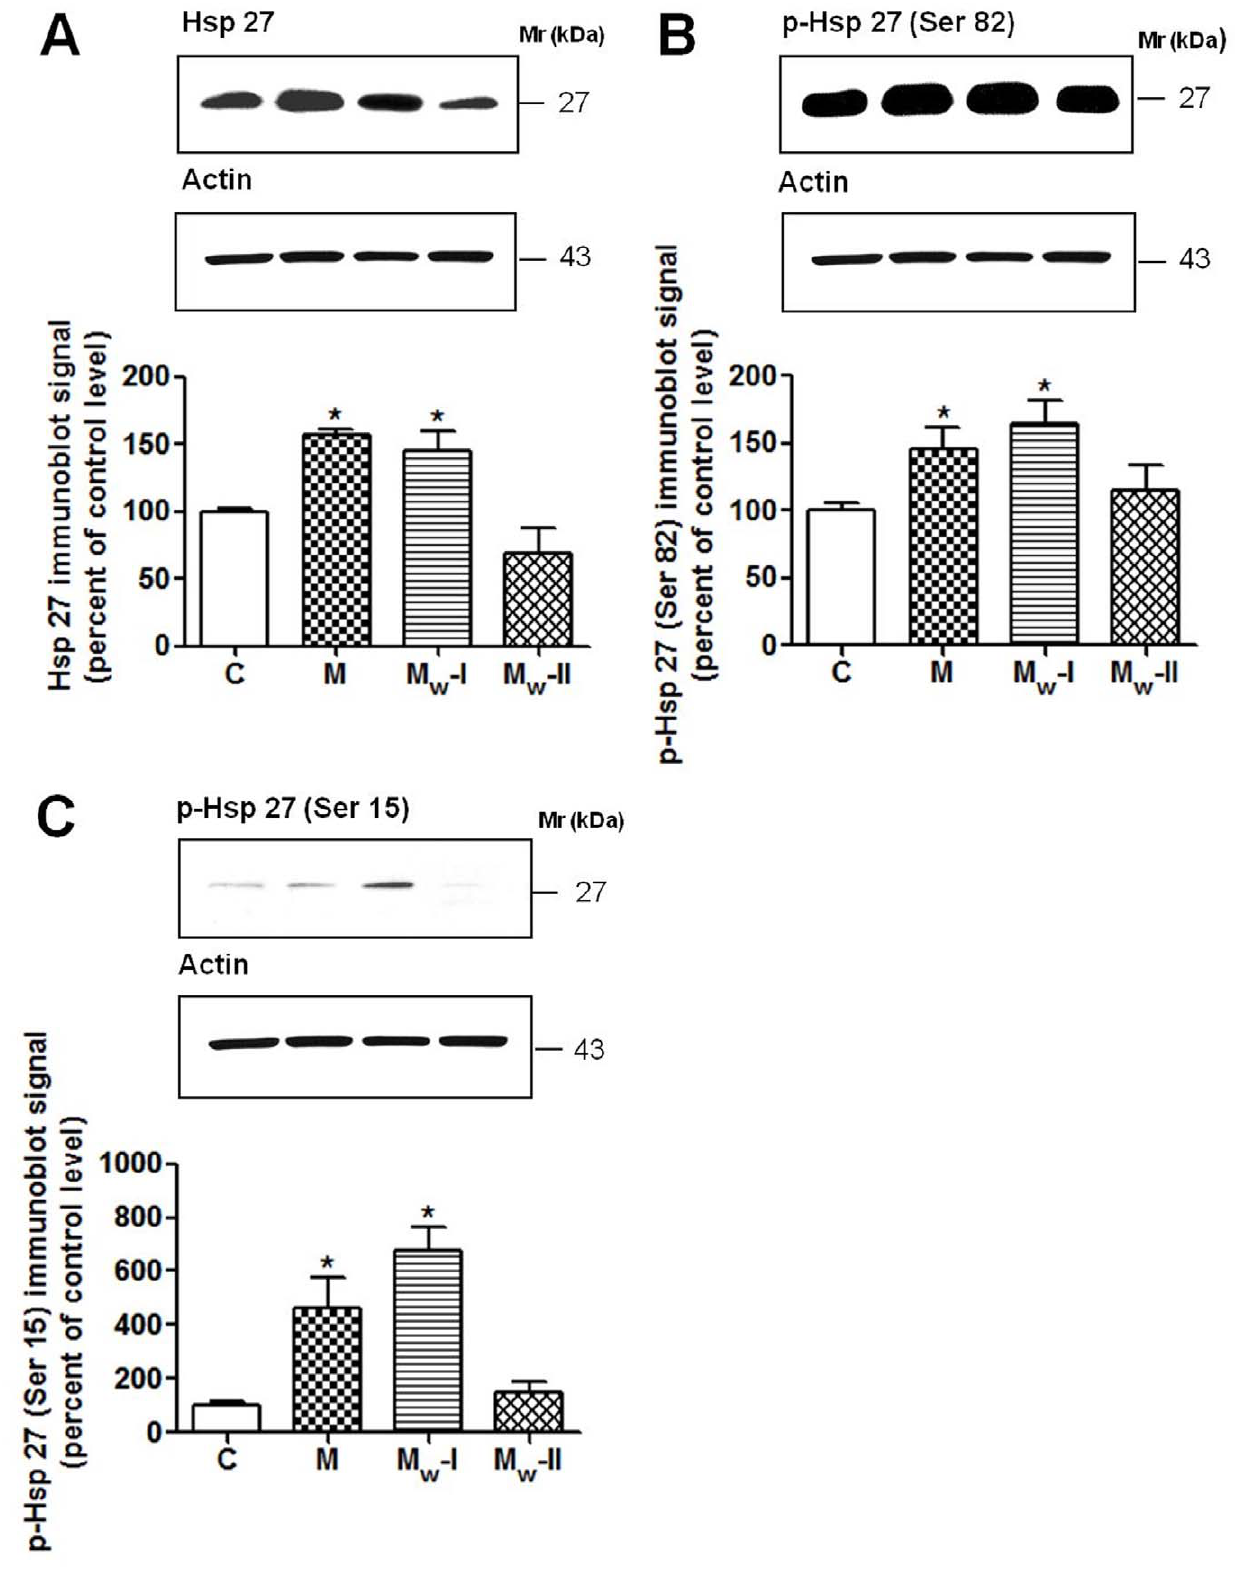
Figure 6. Immunoblot analyses of the unphosphorylated and phosphorylated forms of HSP27. Cytosolic proteins (20 m g) isolated from the left ventricular myocardium of control (C), morphine-treated (M), and morphine-withdrawn for 3 days (M W -I) or 6 days (M W -II) rats were separated on 15% polyacrylamide gels by SDS-PAGE and electrotransferred onto the nitrocellulose membrane. Specific primary antibodies were used for the